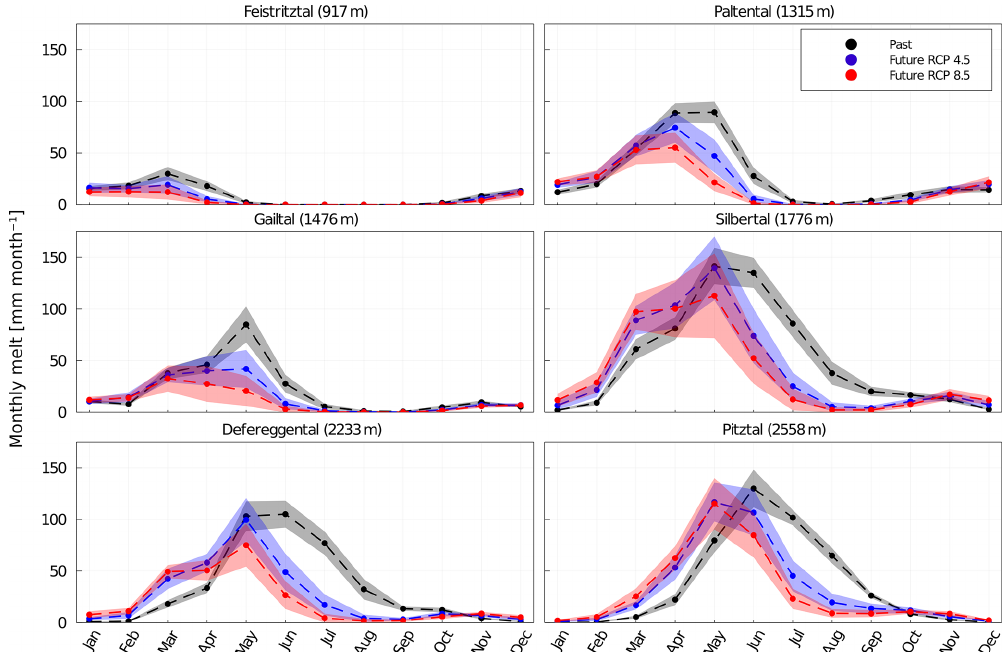
Figure 10. Mean monthly melt contributions in the past (black dots) and future (blue dots – RCP4.5; red dots – RCP8.5) over the time period of 30 years. The shaded areas indicate the associated ± 1SD (standard deviation; gray – past; blue – RCP4.5; red – RCP8.5). Dashed lines between the individual months are used for better